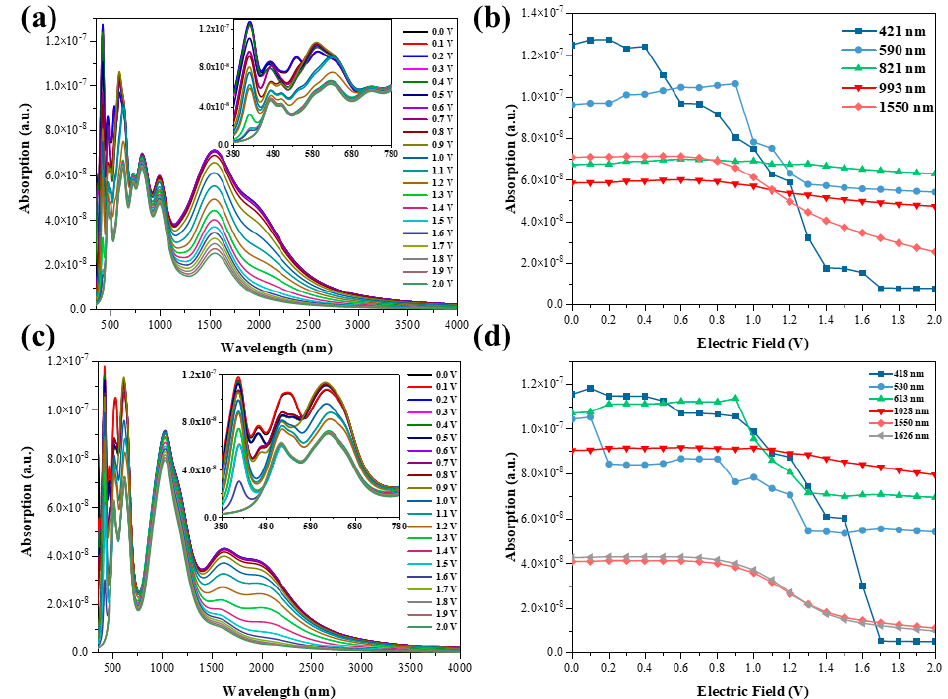
Figure 2. ( a ) Optical absorption spectrum of TBG induced by external electric field in xx direction; ( b ) the change of absorption intensity for tunable electric fields in xx direction; ( c ) optical absorption spectrum of TBG induced by external electric field in yy direction; ( d ) the change of absorption intensity for tunable electric fields in yy